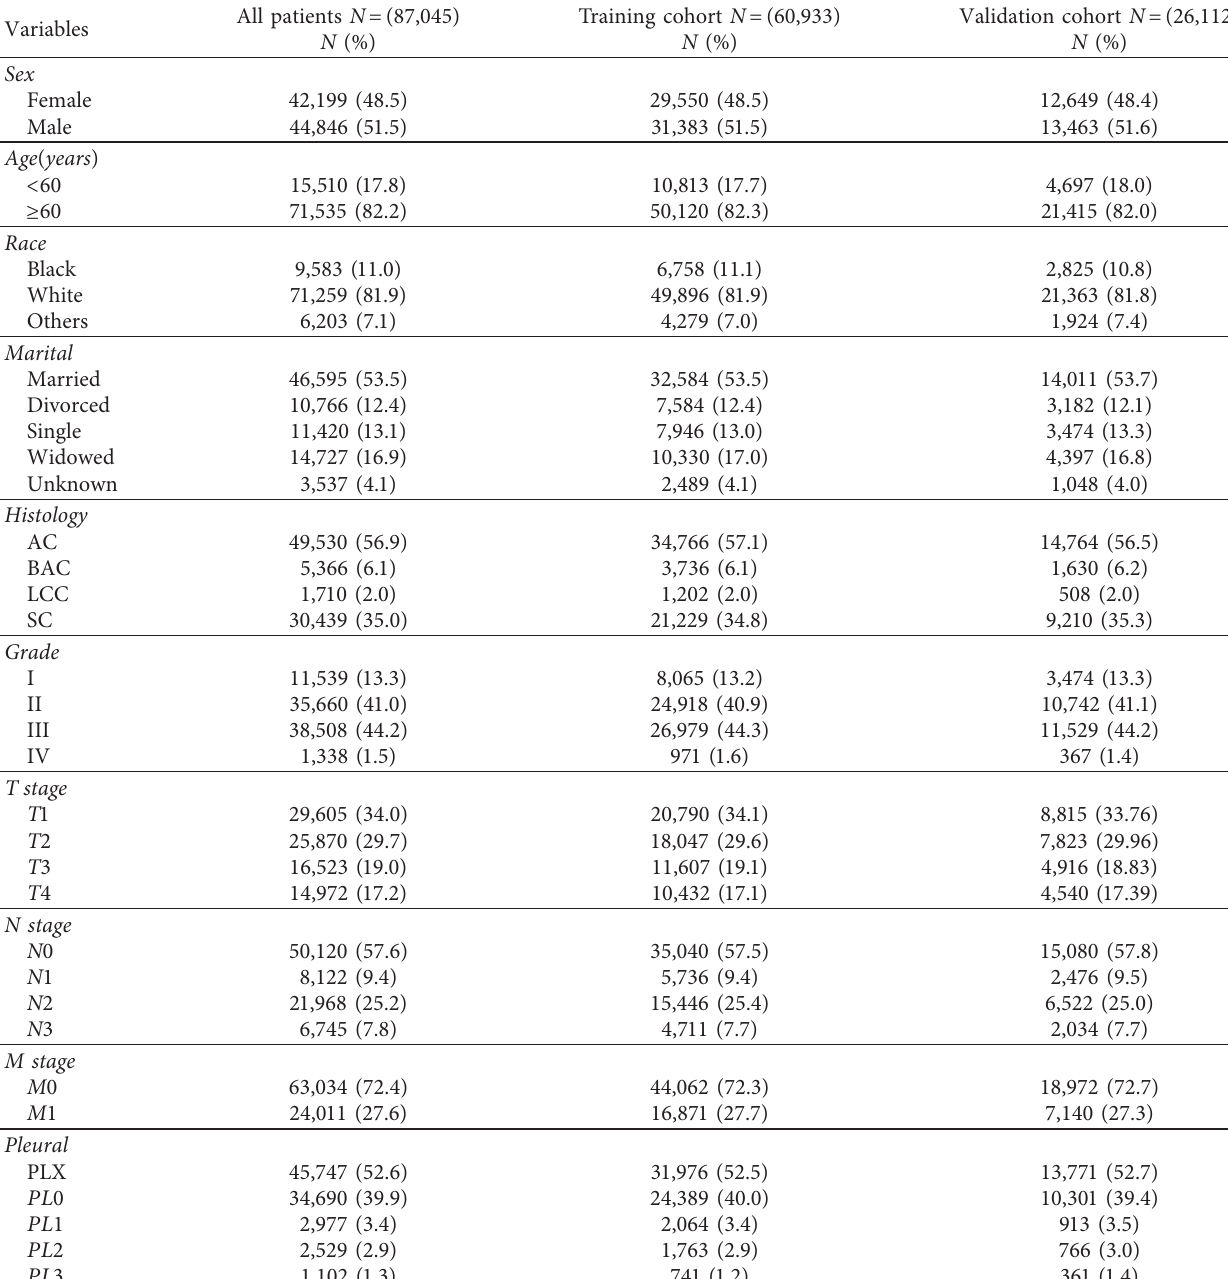
Table 1: Characteristics of NSCLC patients with the different subdivision levels of